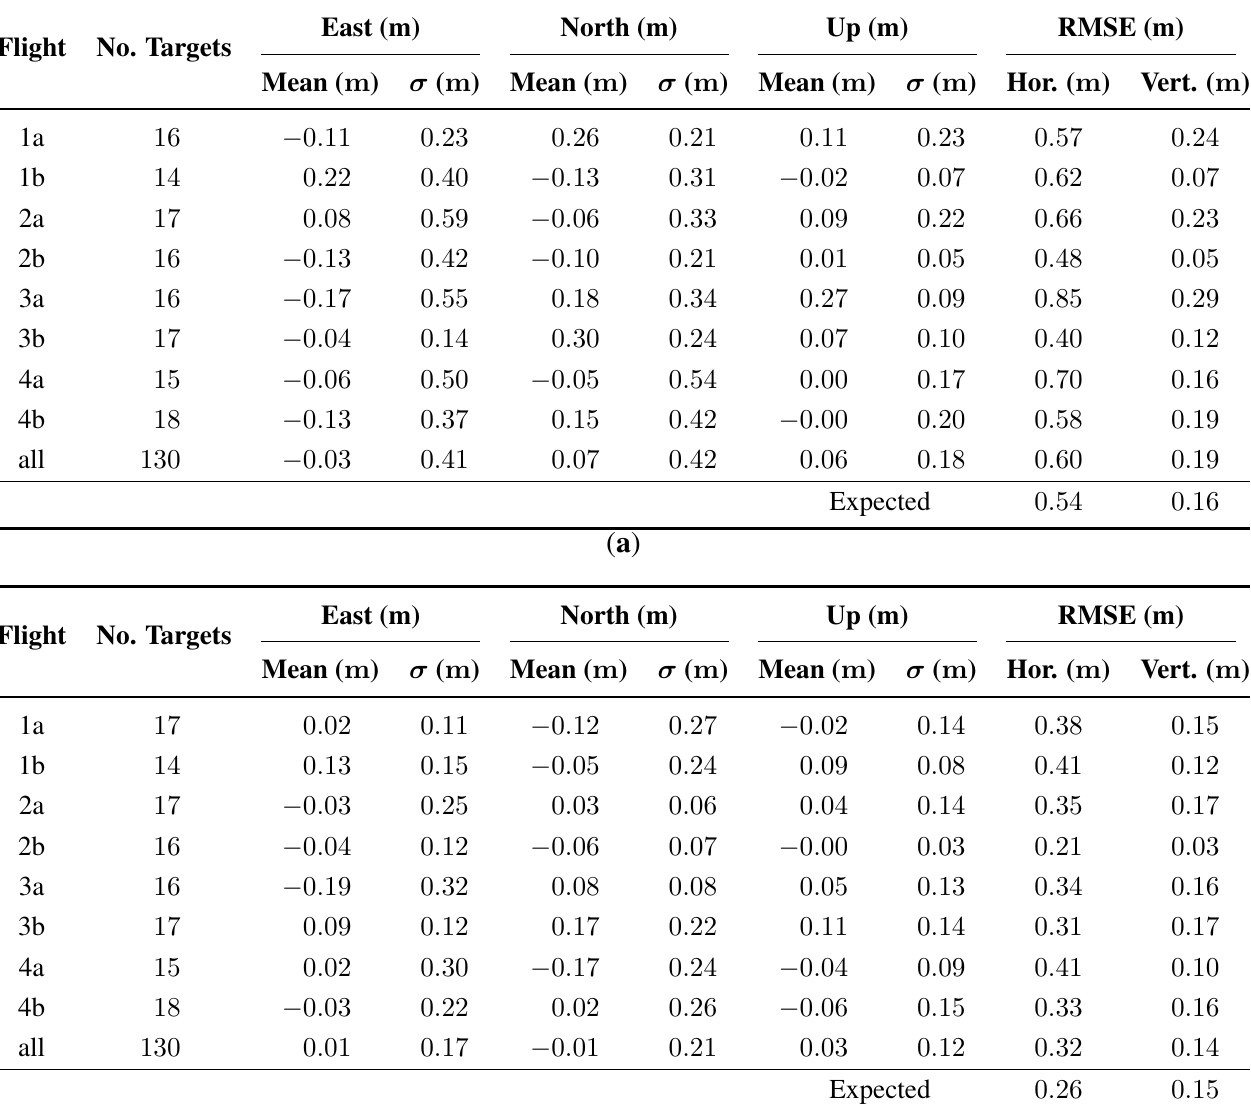
Table 4. Mean, Standard Deviation and RMS error in the differences between the ground control location measured by the LiDAR system without ( a ) and with ( b ) SfM observations in comparison to the locations measured by a differential GPS survey. The expected values as derived from stochastic modelling are also included as derived in Wallace et al.